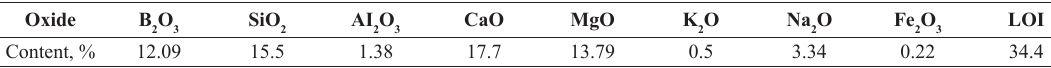
Table 1. Chemical content of wastes including boron.